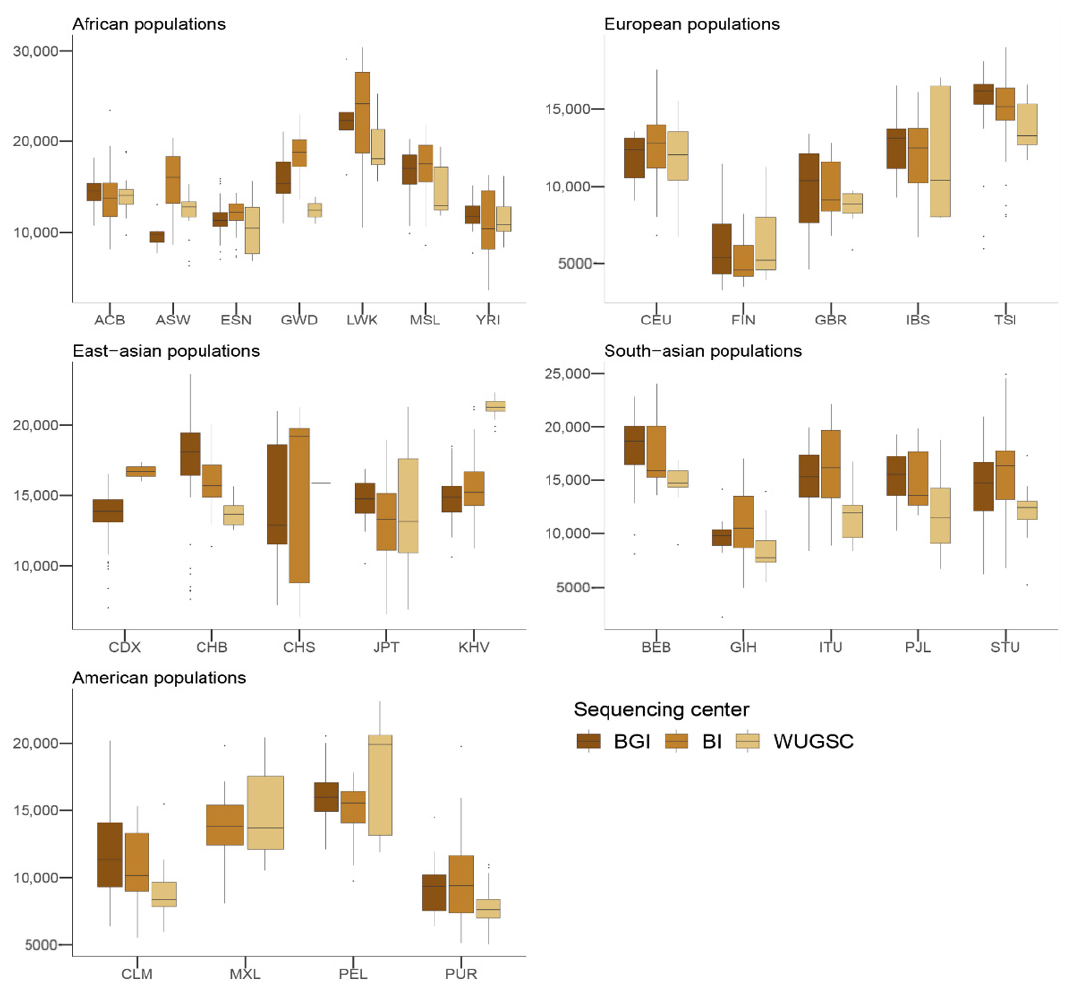
Figure 5. Number of singletons by sequencing centers across continental groups and populations. Each panel corresponds to a continental group. In the x-axis the name of the population is displayed; in the y-axis the number of singletons per individual is displayed. Acronyms are showed in Supplementary Materials Table S1.